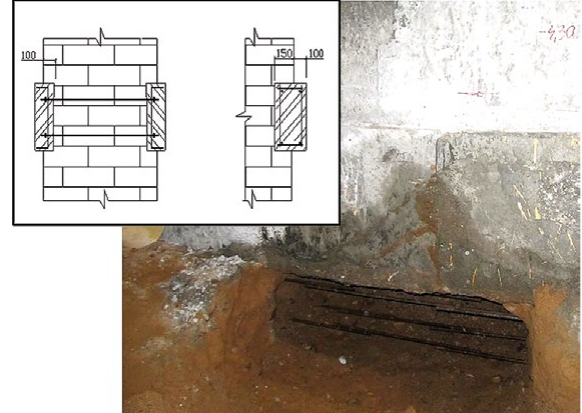
Fig. 7. To unify deformation, steel and reinforced concrete beams and longitudinal reinforcement of excavations are used